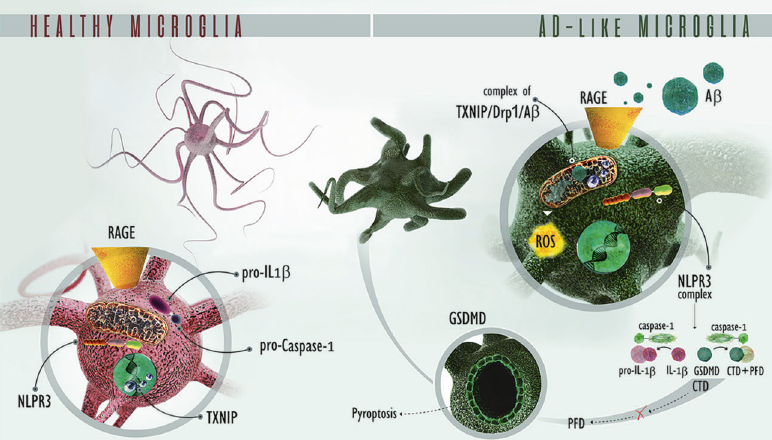
Fig. 7 Schematic representation of the RAGE – TXNIP pathway implicated in microglia dysfunction in an AD contest. RAGE – TXNIP drives A β from the cell surface to mitochondria, leading to Drp1 oligomerization and translocation to mitochondria. These events lead to NLRP3 complex formation, resulting in caspase-1 activation, which in turn results in IL-1 β secretion and GSDMD cleavage, producing CTD and PFD. The Pore Forming Domain (PFD) of cleaved GSDM assembles at the plasma membrane, inducing pyroptosis. RAGE receptor for advanced glycation endproducts. TXNIP thioredoxin-interacting protein. AD Alzheimer ’ s disease. A β Amyloid-beta peptide. Drp1 Dynamin-related protein 1, NLRP3 NOD-like receptor family, pyrin domain containing 3. Pro-IL-1 β pro-interleukin 1 beta, IL-1 β interleukin 1 beta, GSDMD gasdermin D, CTD C terminal domain (of GSDMD), PFD pore-forming